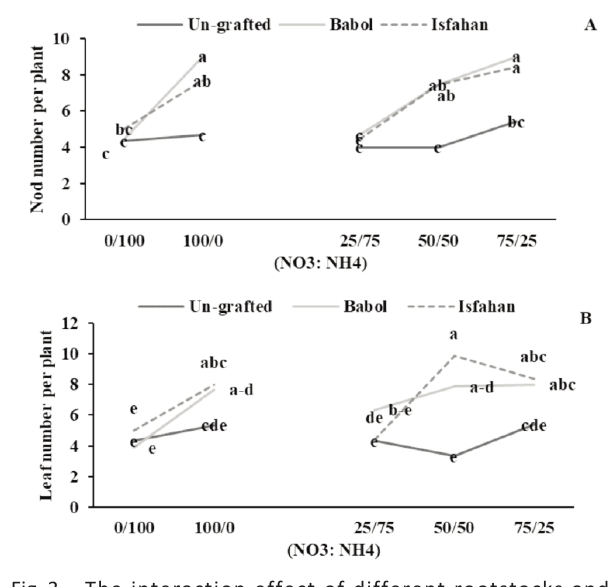
Fig. 3 ­ The interaction effect of different rootstocks and NO :NH ratio on A) number of leaves and B) number of 3 4 nodes.